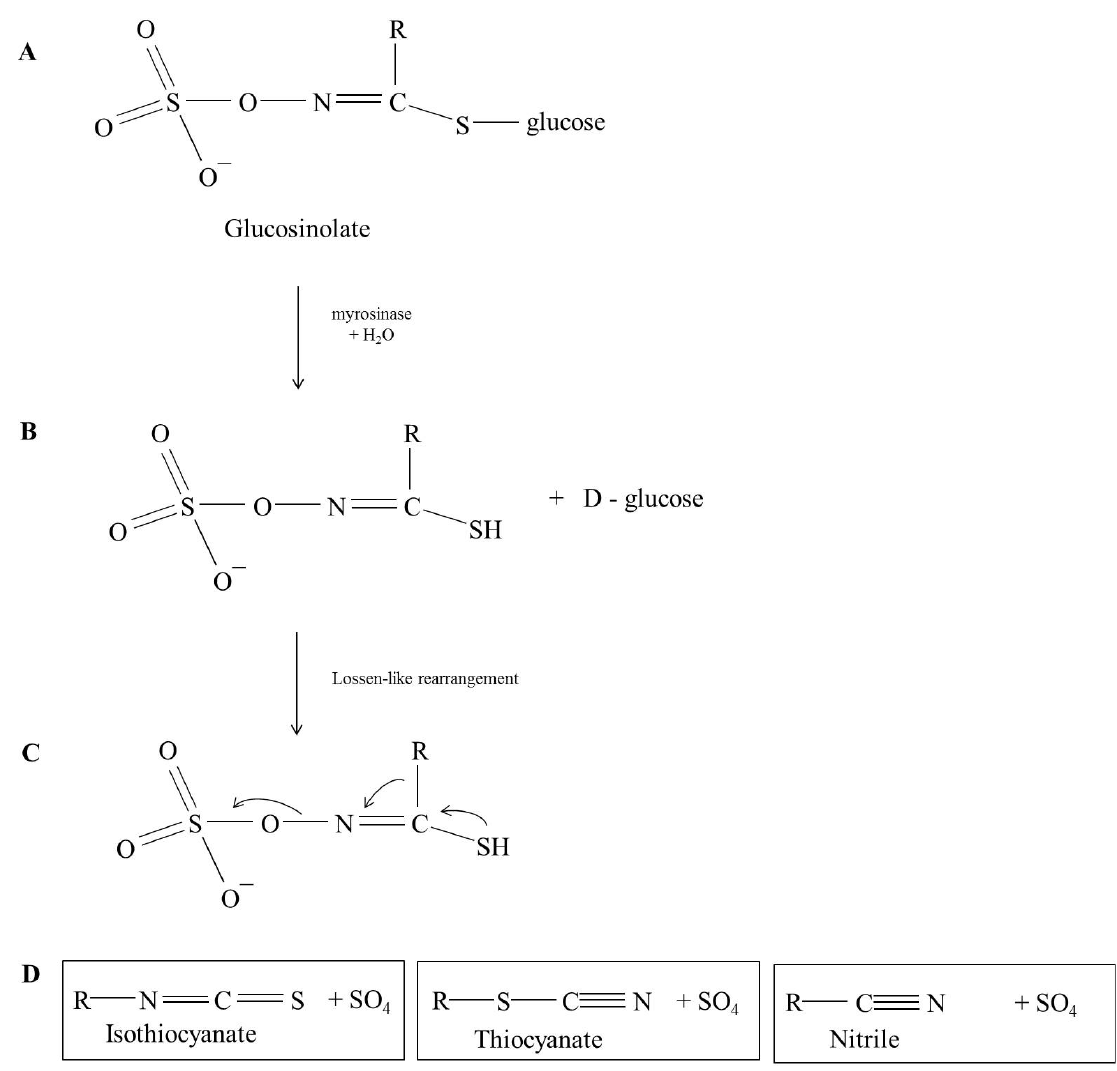
Figure 1. Myrosinases catalize the hydrolysis of glucosinolates ( A ) yielding D -glucose and aglycone ( B ); Depending on the physiological conditions, the aglycone undergoes a Lossen-like rearrangement ( C ) releasing sulfate and isothyocianates, thyocianates or nitriles ( D